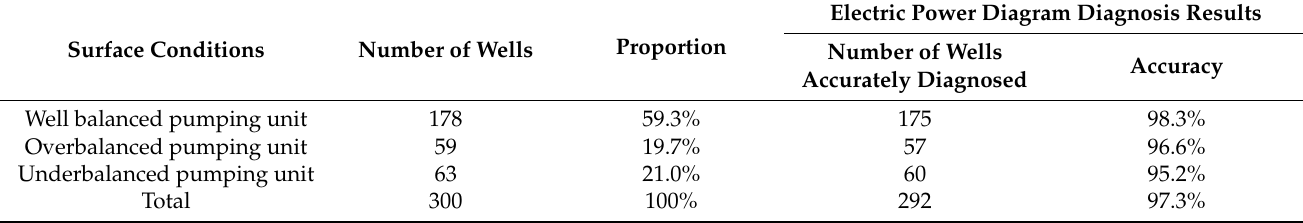
Table 6. Diagnosis results of surface